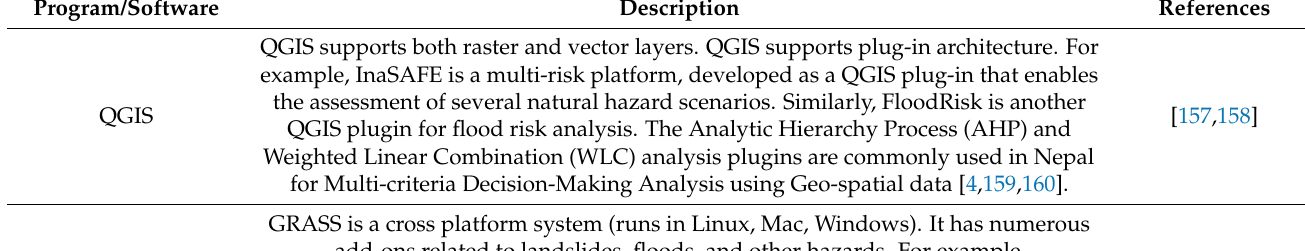
Table 7. Open-source GIS program/software application for flood risk